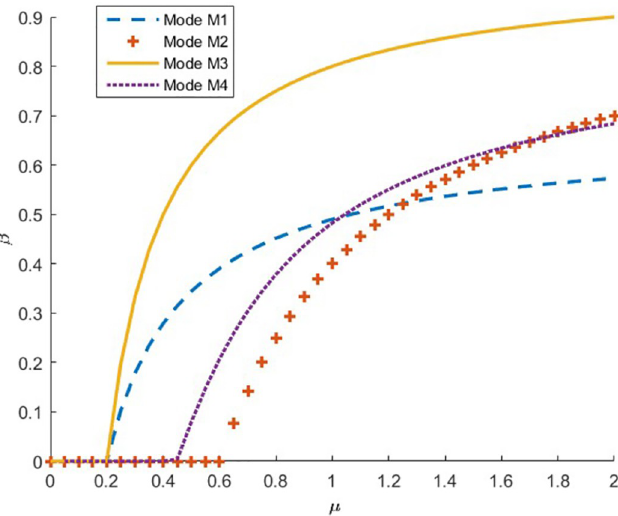
Fig 4. The influence of parameters μ on donation